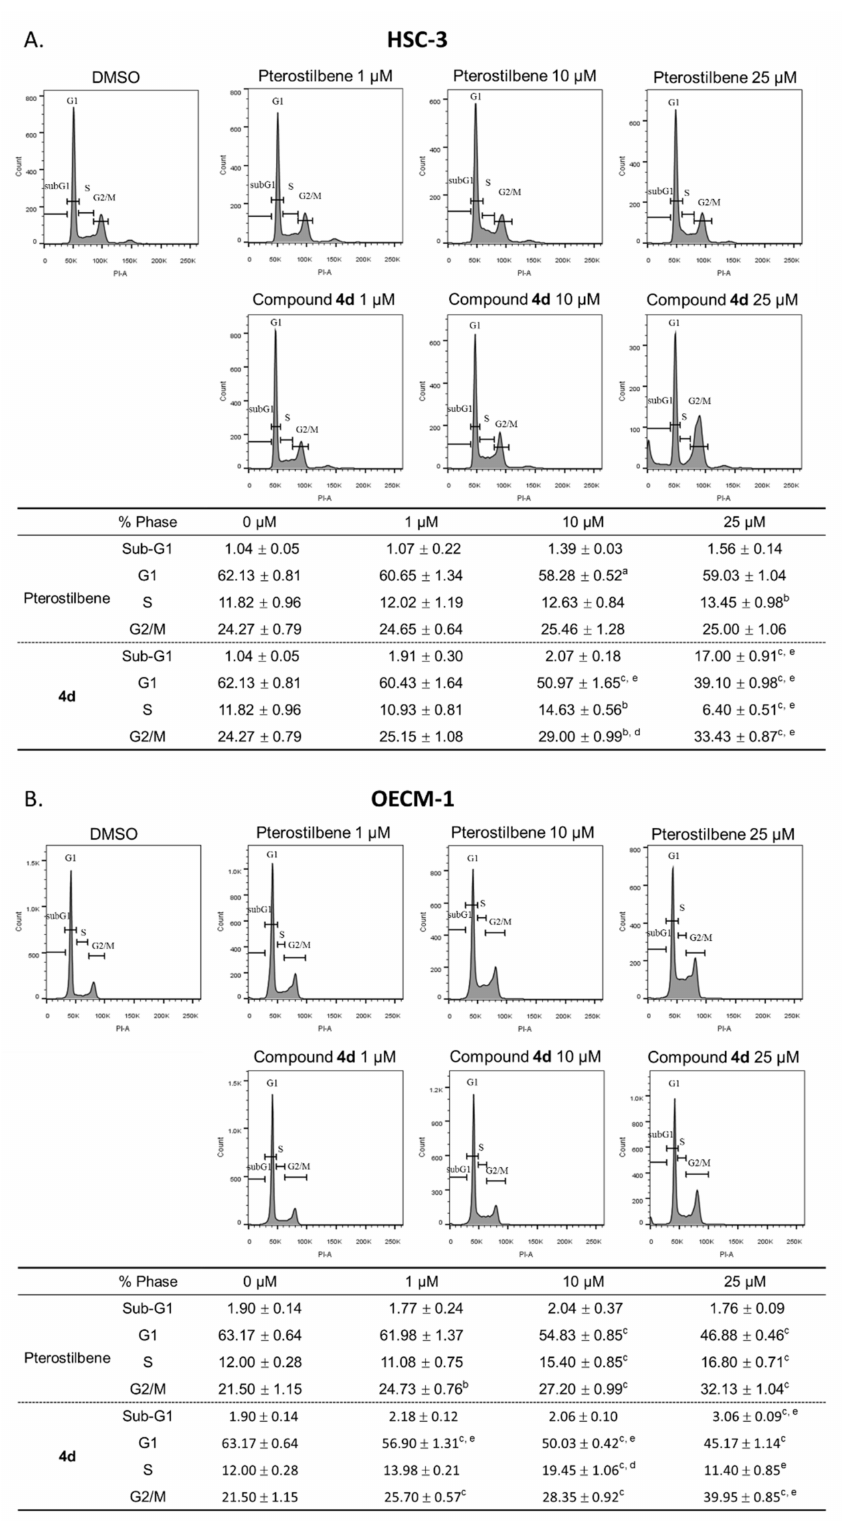
Figure 4. The effect of G2/M phase arrest induced by compound 4d . For cell cycle analysis, ( A ) HSC-3 and ( B ) OECM-1 cells treated by compound 4d or Pterostilbene for 24 h were subjected to PI staining, flow cytometric analysis, and quantitative analysis. Statistically significant differences are indicated as follows: a p < 0.05; b p < 0.01; c p < 0.001 between each group and vehicle control; d p < 0.01; e p < 0.001 between compound 4d treatment and the same concentration of pterostilbene